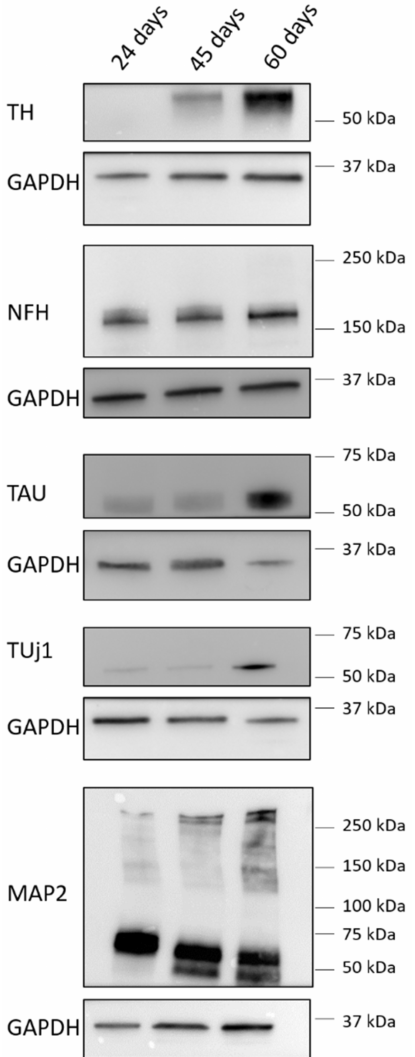
Figure 2. Evaluation of neuronal markers’ expression during differentiation of iPSCs into dopaminer- gic neurons. Representative immunoblotting images of the expression of tyrosine hydroxylase (TH), neurofilament H (NF-H), TAU, β -III-tubulin (TUJ1) and microtubule-associated protein 2 (MAP2) in iPSCs differentiated into DA neurons for 24, 45 and 60 days. Housekeeping GAPDH expression has been used as the loading